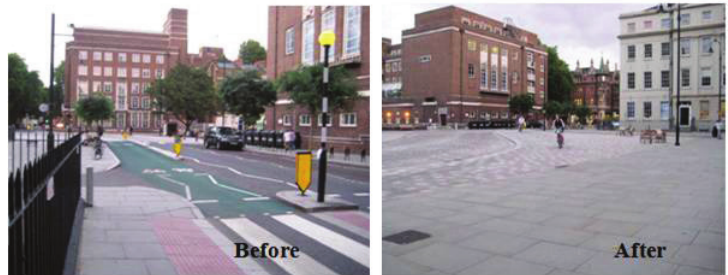
Figure 3. Changes made to Byng Place, London